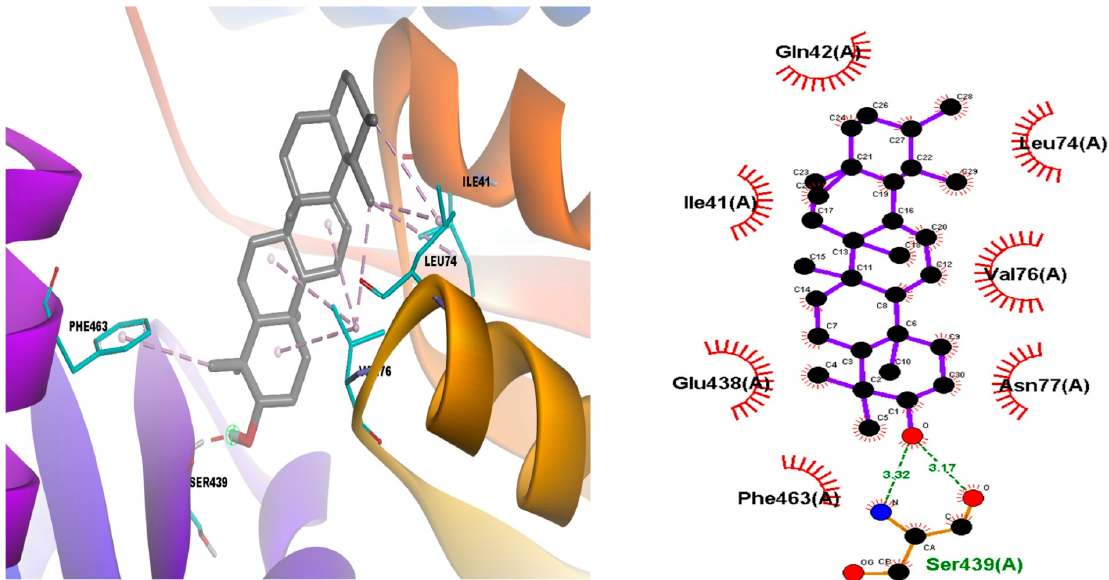
Figure 6. Methyl commate A compound interaction of allosteric binding sites of target proteins pyruvate kinase (PDB: 1PKL).